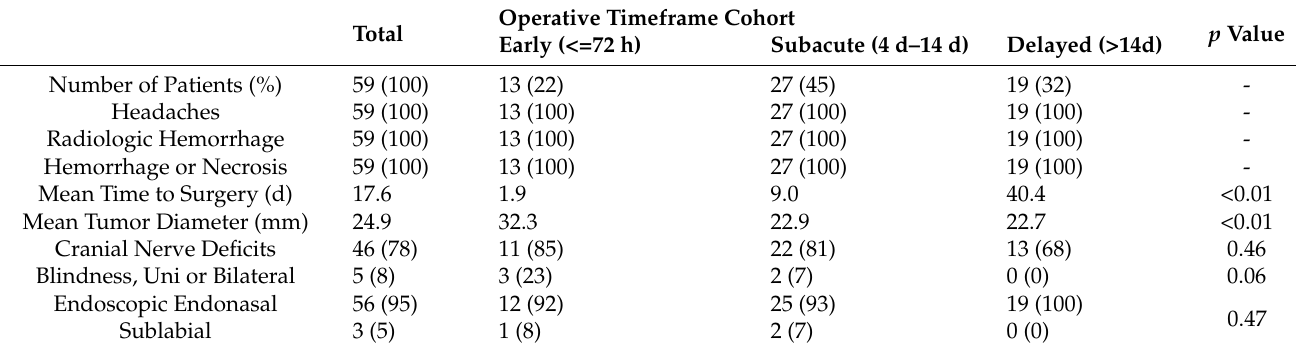
Table 1. Baseline Characteristics of Study